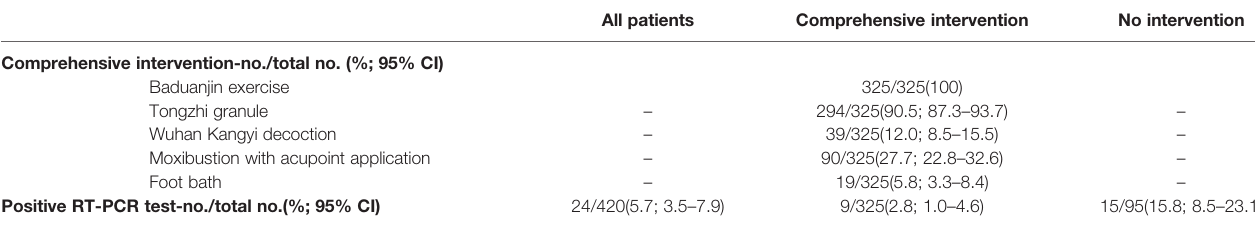
TABLE 2 | Comprehensive intervention and Positive RT-PCR test.